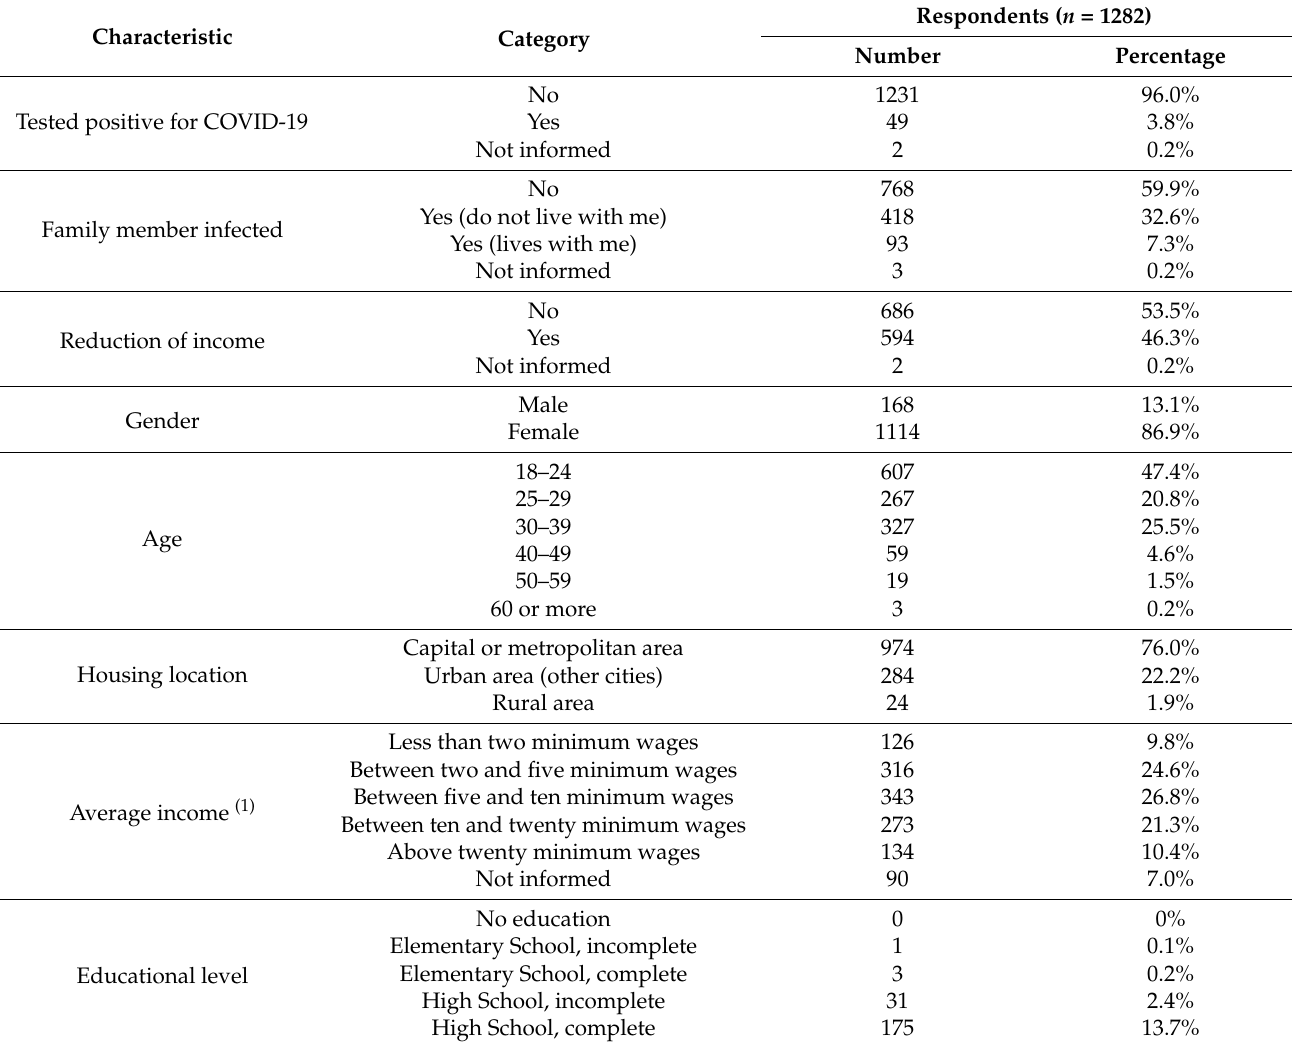
Table 1. Characteristics of the study